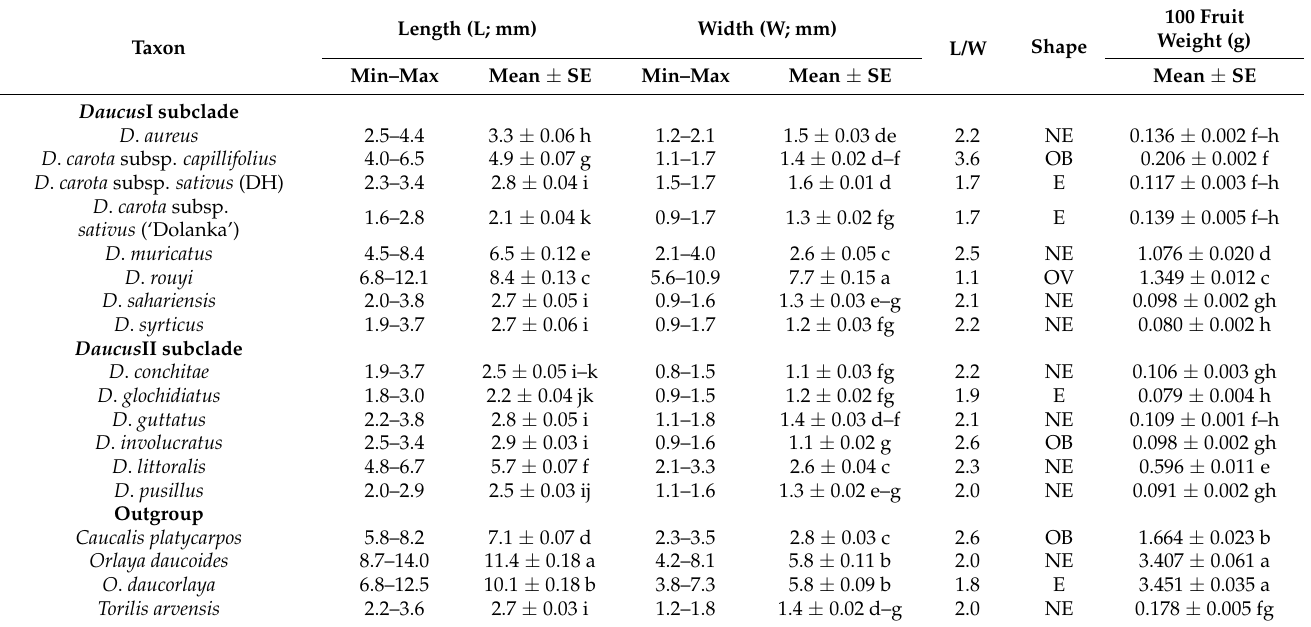
Table 1. Fruit (mericarp) morphological characteristics of the investigated Daucus and closely related non- Daucus (outgroup)